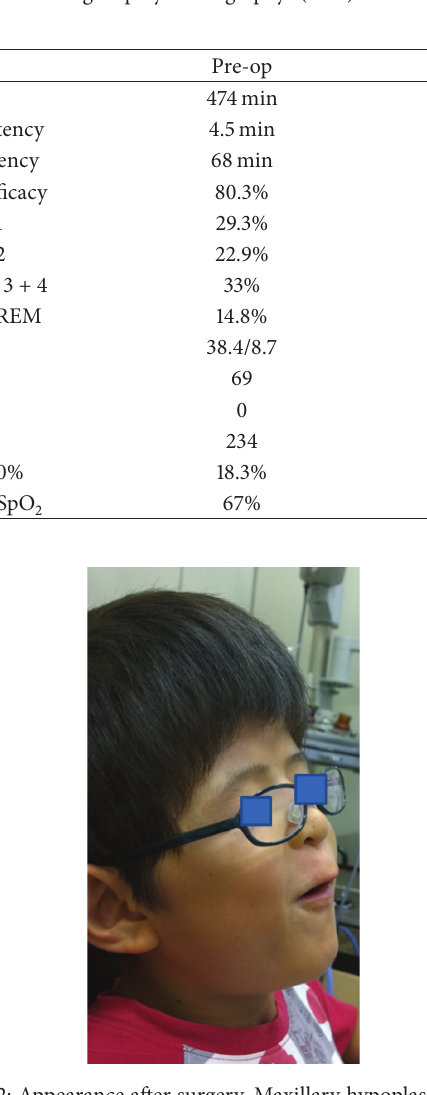
Figure 2: Appearance after surgery. Maxillary hypoplasia, because of which the mouth remained constantly open, and malocclusion have been corrected after surgery.